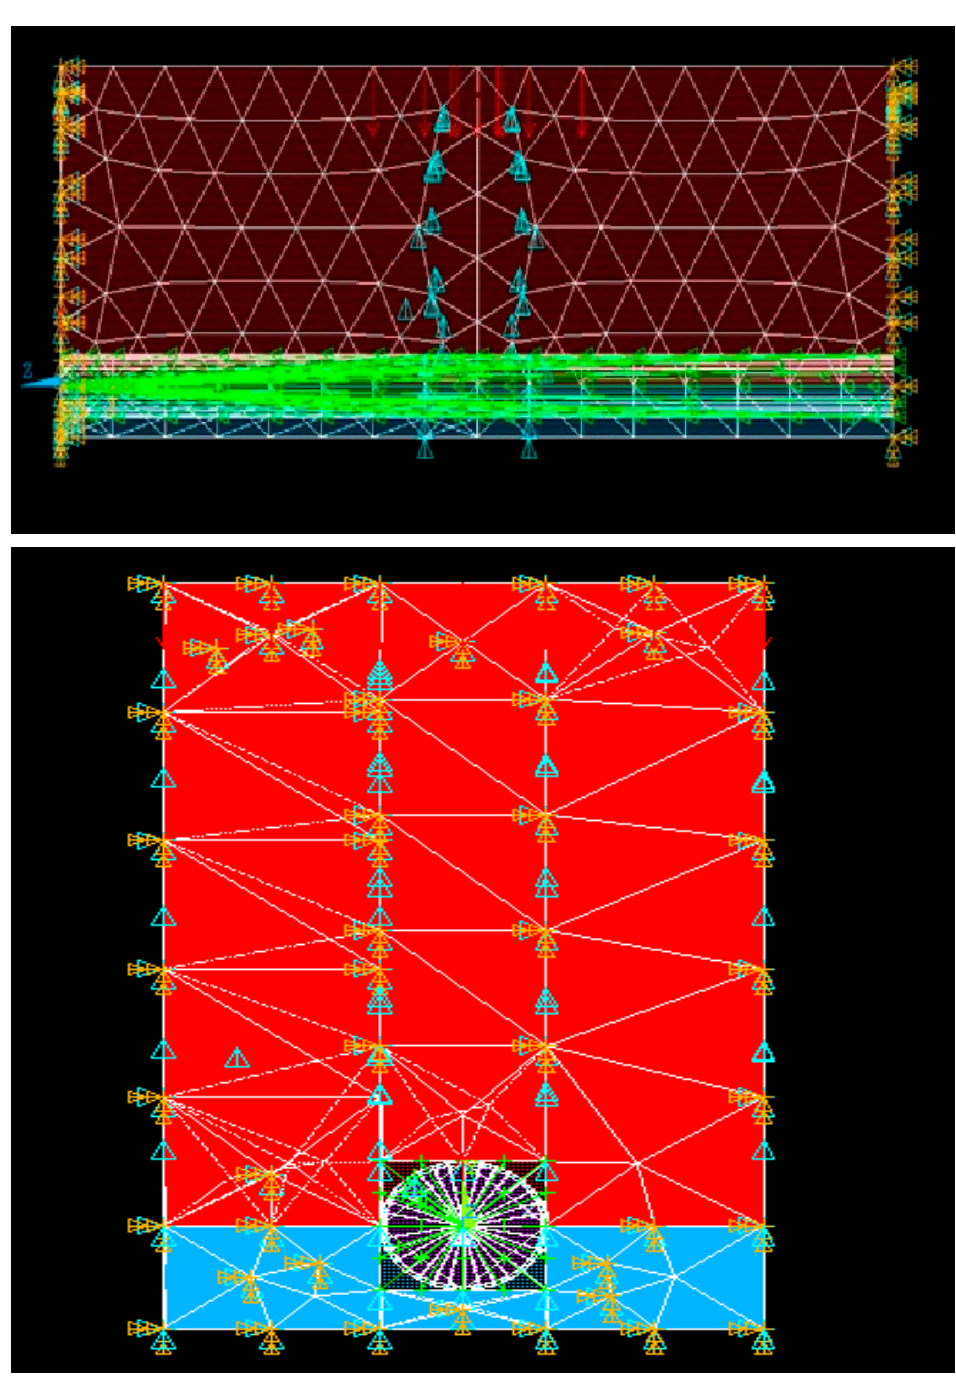
Figure 15. Application of fixed-support on both sides of the FE model of soil–GPC pipe in ANSYS.